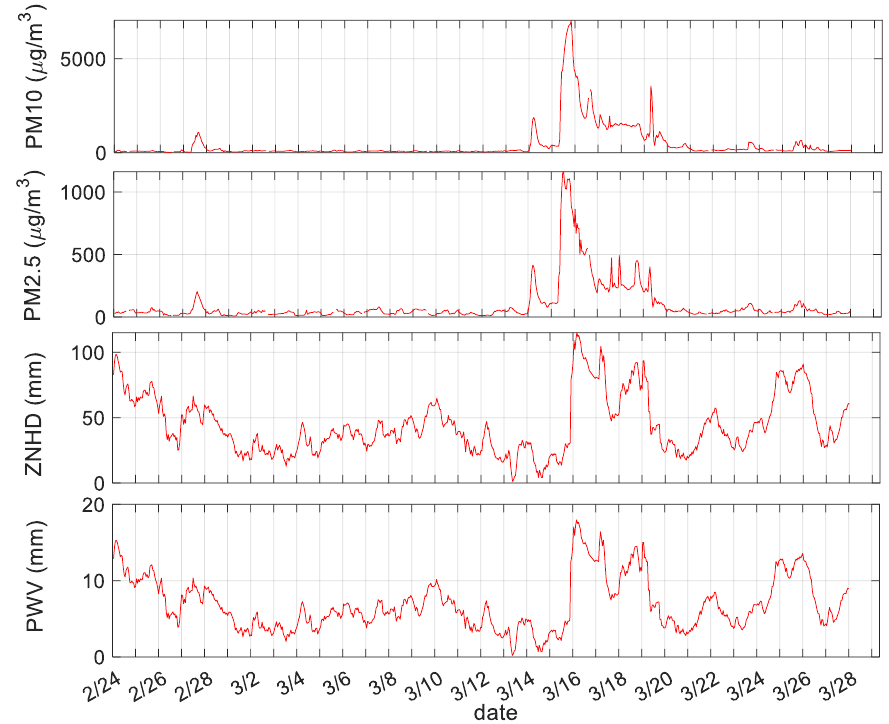
Figure 6. Changes in PM10, PM2.5, ZNHD and PWV at GSPL station. As can be seen from Figure 6, a small-scale dust storm occurred in Pingliang City on the 28th of February, and both PM10/PM2.5 and ZNHD/PWV increased significantly. The concentrations of PM10 were greater than 2000 μg/m 3 on 15 March 2021, about 6.9 times higher than usual. The concentrations of PM2.5 were greater than 200 μg/m 3 on the 15th of March 2021, about 2.4 times higher than usual. From the 16th of March to the 20th of March, the change trend of ZNHD/PWV is very consistent with the change trend of PM10/PM2.5. Both PM10/PM2.5 and ZNHD/PWV have obvious abnormalities from the 16th of March to the 20th of March. From the 25th of March to the 27th of March, ZNHD/PWV increased significantly. According to the website of the China Meteorologi- cal Administration, there was obvious rainfall in Pingliang City during this period. In summary, the occurrence of sandstorms can be detected by using the GNSS-de- rived ZNHD/PWV. However, GNSS-derived ZNHD/PWV is also affected by abnormal weather such as rainfall, snowfall, and haze. Therefore, when using the GNSS-ZNHD to detect sandstorms, it is necessary to consider the impact of rain, snow and haze. From the Figures 3 – 6, sandstorms have a greater impact on PM10 than PM2.5, and the changes in ZNHD and PWV are highly consistent. Therefore, in order to discover the relationship more intuitively between ZNHD/PWV and PM10, we examined statistics of the correlation between ZNHD and PM10 before, during and after the occurrence of sand- storms. At the same time, we tested the significance level of